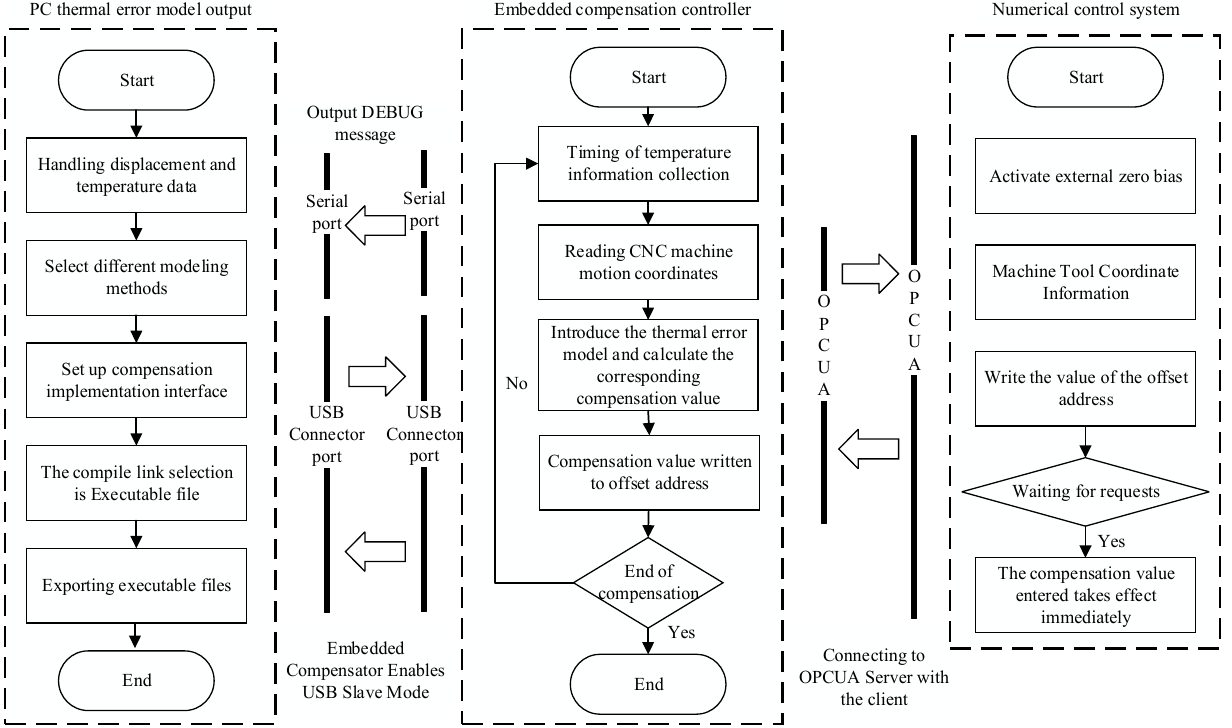
Figure 4. Thermal error compensator compensation implementation process.